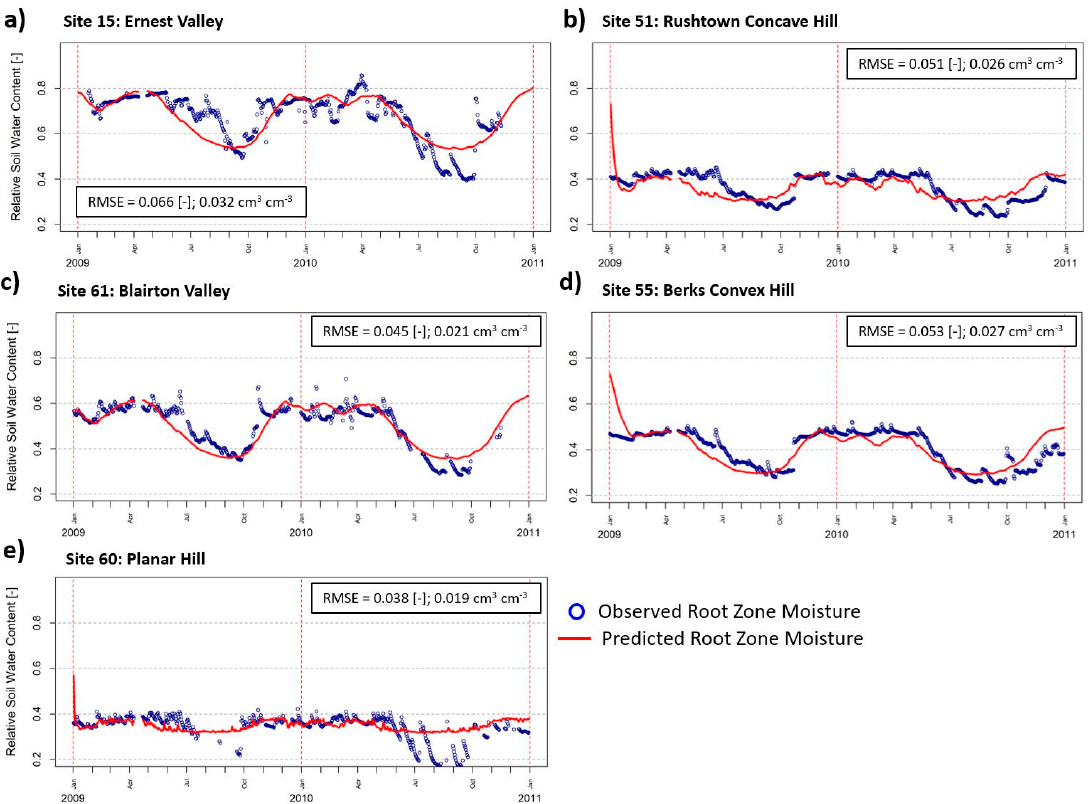
Figure 3. Time-series of the Shale Hills automatic root-zone soil moisture measurements taken during the model calibration period (2009–2011) at each of the five monitoring locations used for model training. Colored lines indicate predictions from the fitted SMAR model, where the advanced microwave scanning radiometer (AMSRE) satellite near-surface soil moisture data is used as a model forcing. ( a ) Ernest valley, ( b ) Rushtown concave hill, ( c ) Blairton valley, ( d ) Berks convex hill, and ( e ) Weikert planar hill.